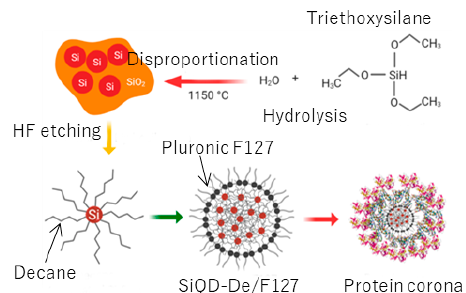
Scheme 1. The schematic diagram for synthesizing the Pluronic-F127 functionalized decyl-coated silicon quantum dots (SiQD-De) nanoparticles and the nanoparticles’ protein corona formation assumption.